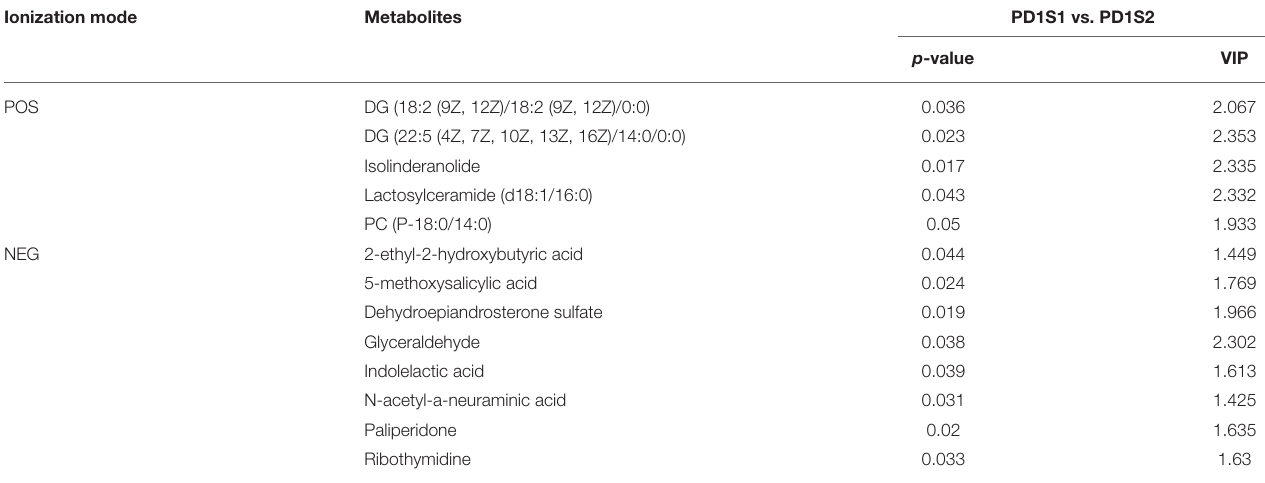
TABLE 3 | In two ionization modes, one-dimensional, and multi-dimensional analysis results of differential metabolites from PD-1 expression level group are